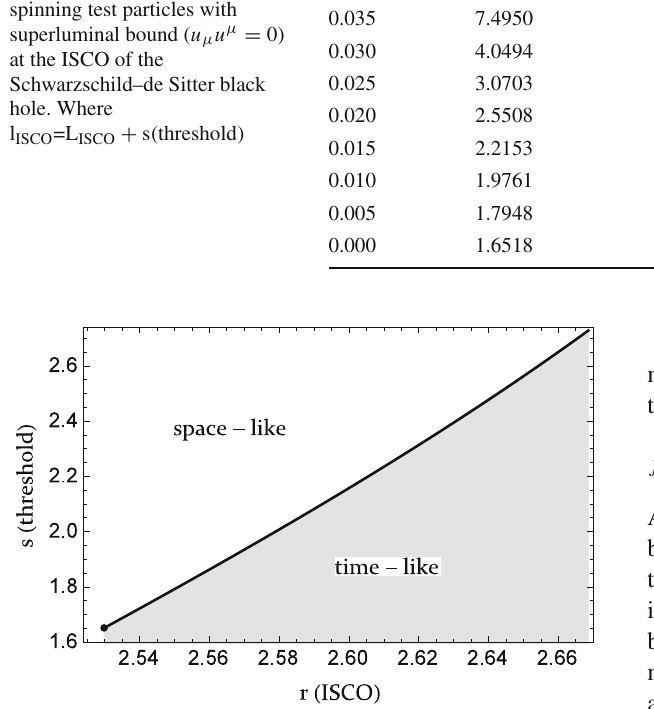
Fig. 3 Relationbetweenthethresholdvalueforthespinoftestparticles and the radius of the ISCO in the Schwarzschild–de Sitter spacetime depending on the cosmological parameter λ ∈ [ 0 , 1 / 27 ] . The solid line correspondstothesolutionofthesuperluminallimitrelation u μ u μ = 0, withtheblackpointatthebottomleftcorrespondingtothesuperluminal limit of the spinning particle at the ISCO of the Schwarzschild black hole ( λ =